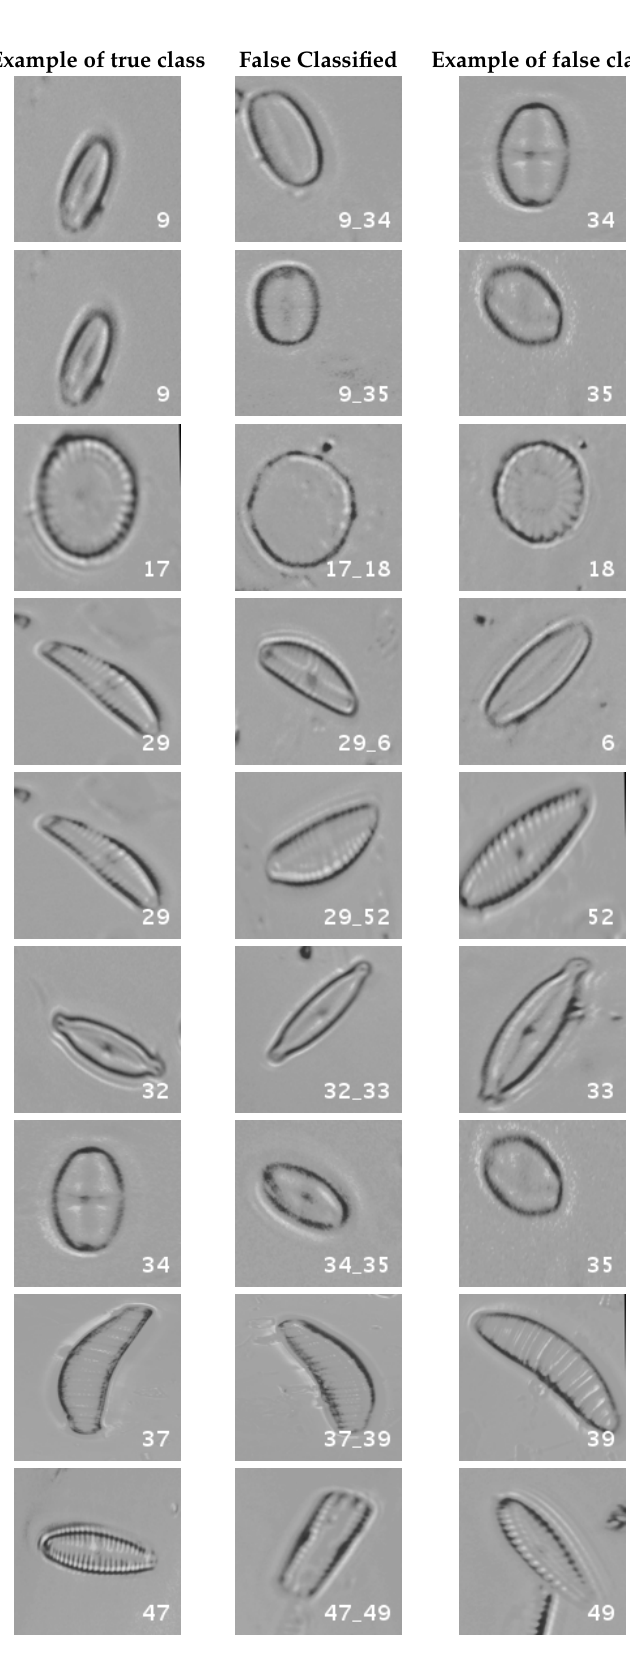
Figure 16. Normalized dataset main confusions (part 1). Each row shows an example of the true species, a missclassifed sample between two species and a sample of the second one are